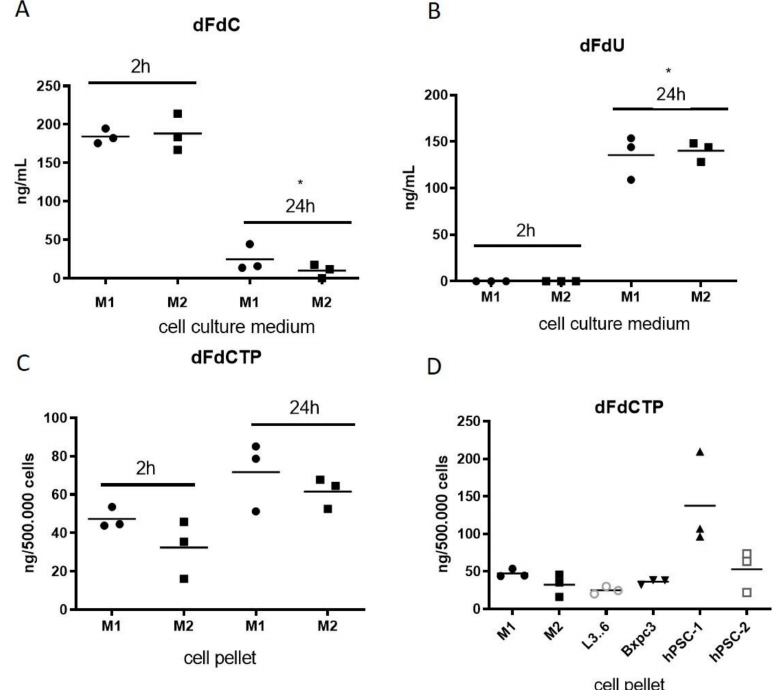
Figure 3. ( A , B ) Pharmacokinetic profile of cell culture supernatant from M1 and M2 THP-1